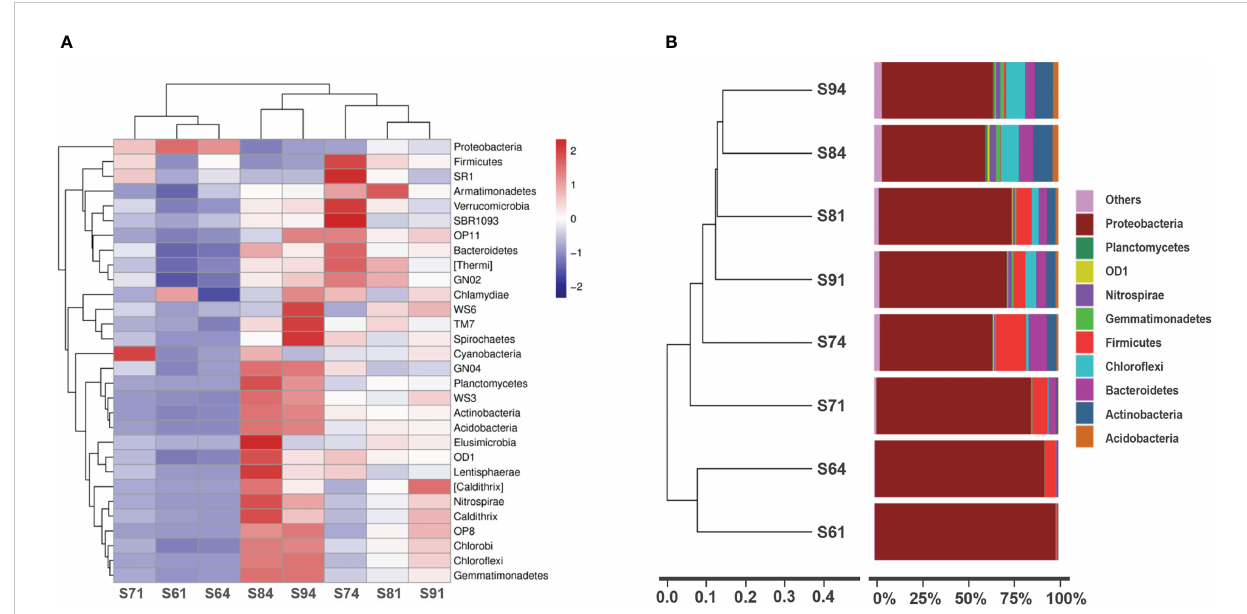
FIGURE 3 Cluster heatmap (phylum level) for community analysis (A) and relative abundances (percent) of dominant lineages (B) in sediment cores of selected layers ( i.e. , the top and the 4 th layer at each site, 8 samples in total). (A) Samples were represented horizontally, and species were represented vertically. The species were clustered on the left and the samples were clustered on the top, re fl ecting the similarity of community composition among samples. (B) The results were clustered on the left to obtain the UPGMA tree based on unweighted Unifrac distance (phylum level). The legend in the bottom left corner represents the distance